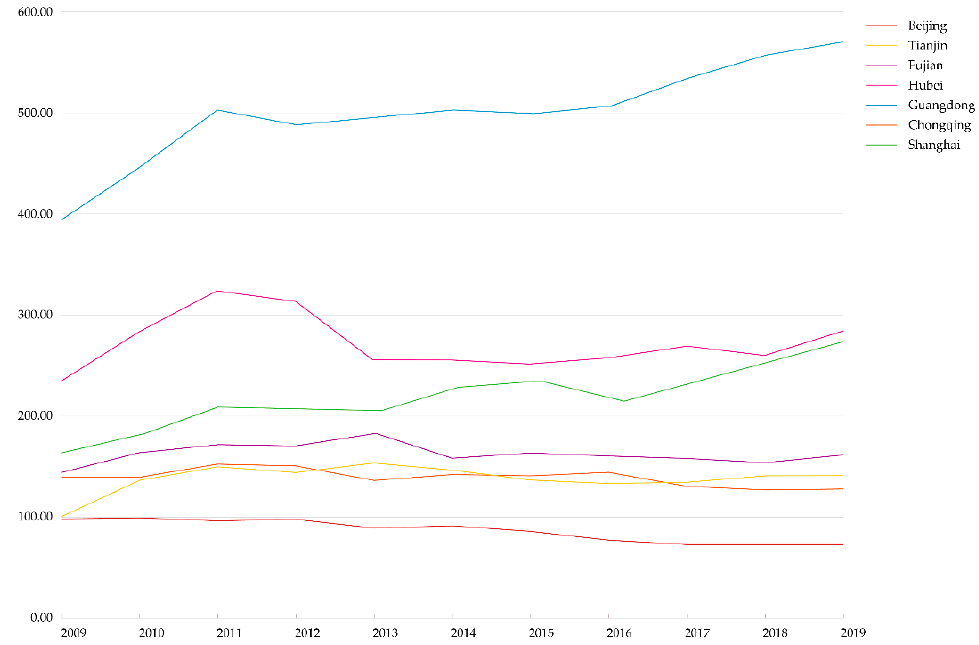
Figure 1. The Carbon Emissions across 7 CCETE provinces in China (2009–2019).